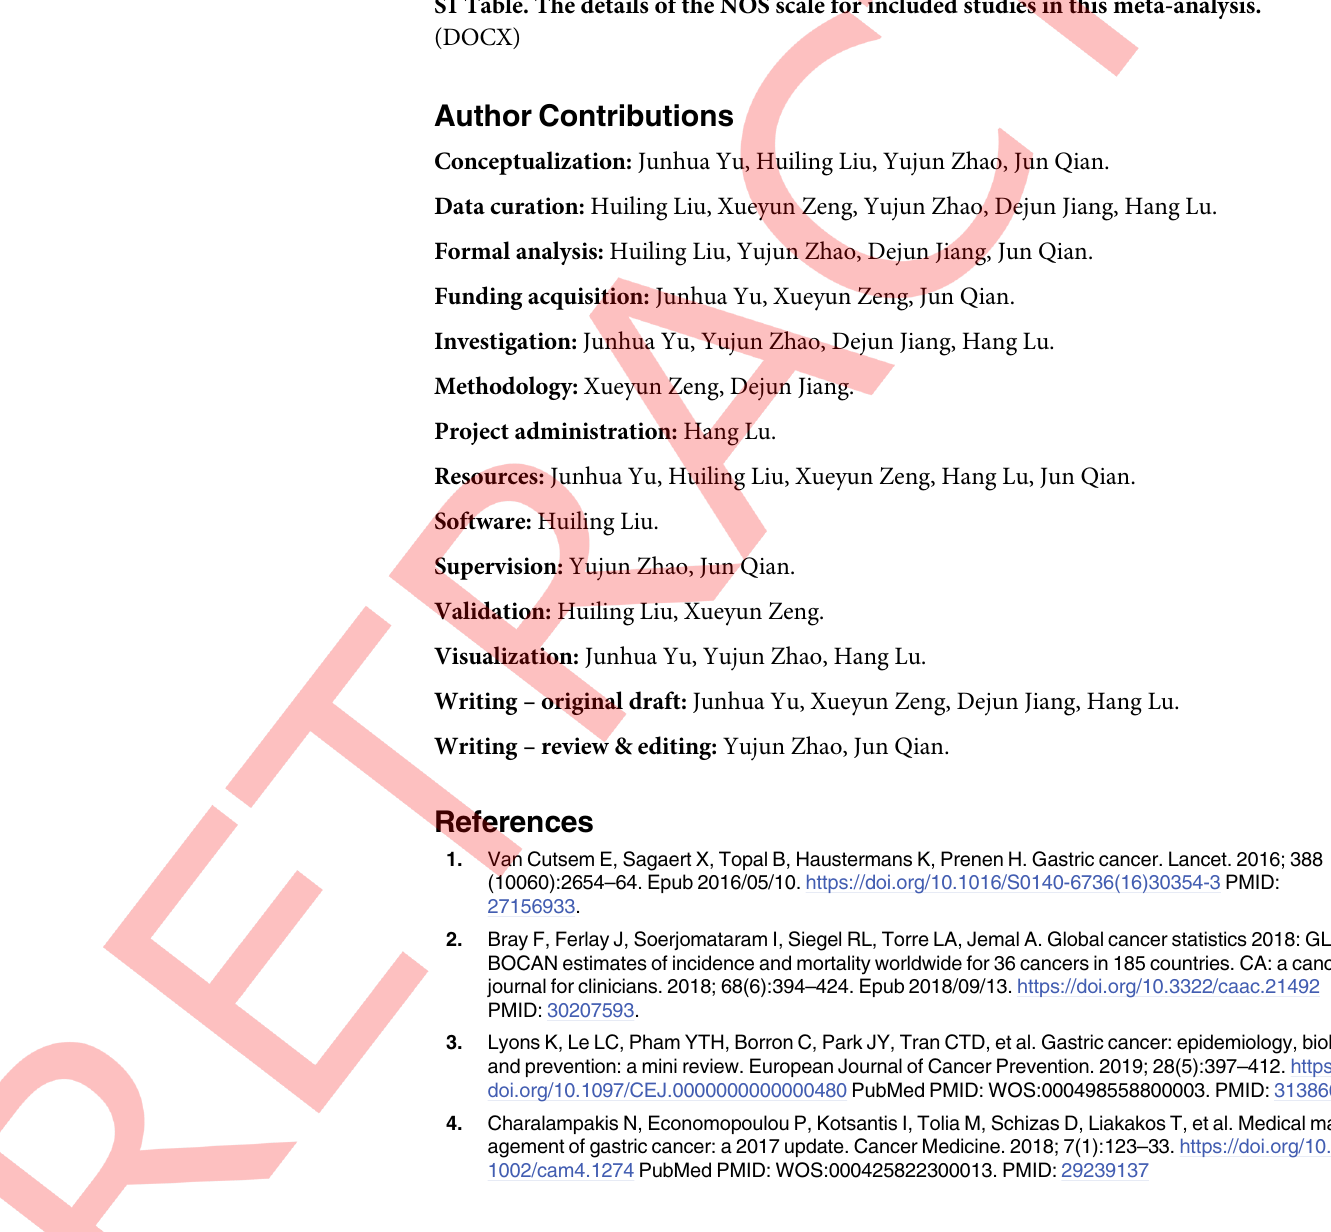
S1 Table. The details of the NOS scale for included studies in this